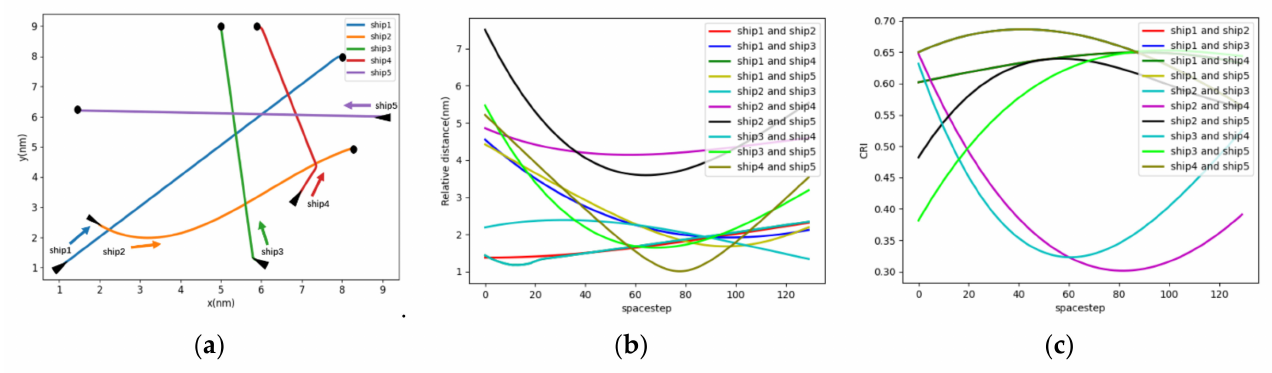
Figure 17. The result of five-ship encounter without measures. ( a ) trajectories; ( b ) relative distance; ( c ) CRI.